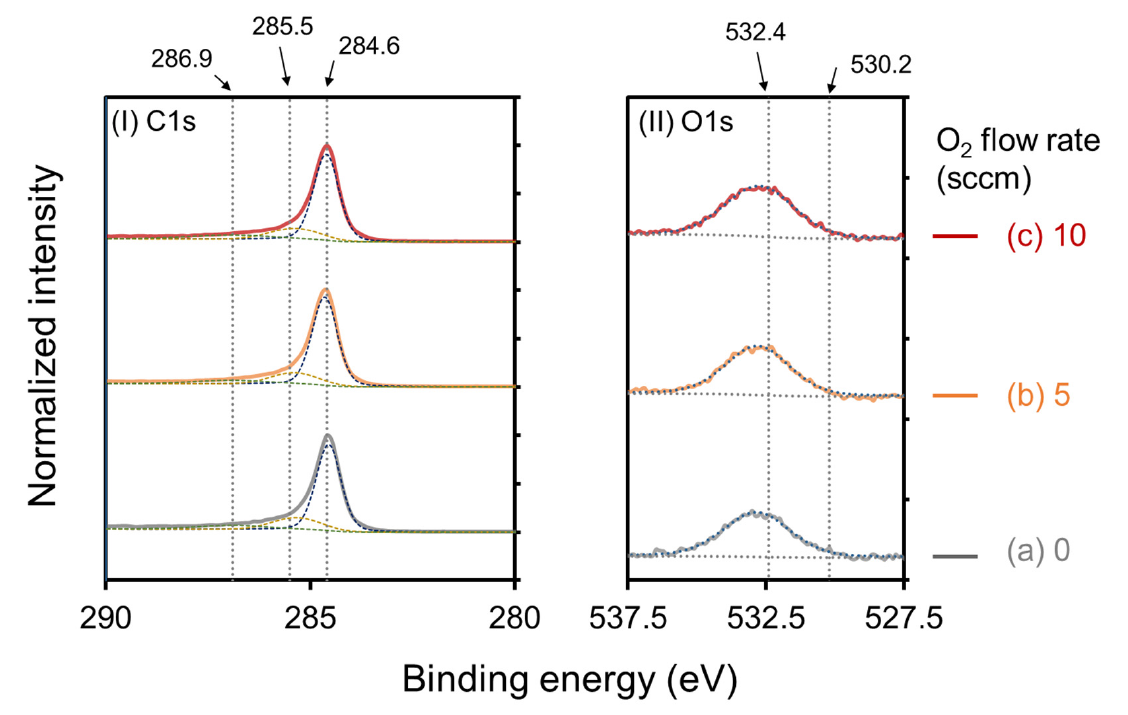
Figure 5. (I) C1s and (II) O1s XPS spectra of ( a ) normal CNWs, ( b ) 5-sccm-O 2 –, and ( c ) 10-sccm-O 2 – high-quality CNWs. The C1s spectra and O1s spectra were normalized with respect to the peak intensities for sp 2 C–C bonds at 284.6 eV.